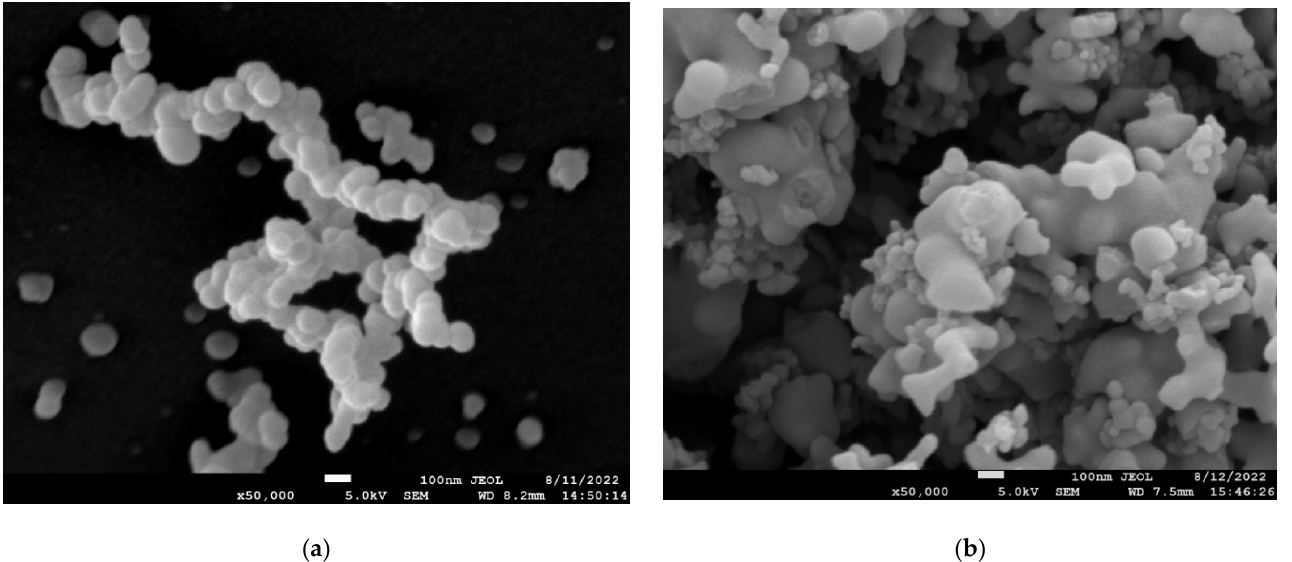
Figure 7. SEM images of char residues of ( a ) pure epoxy resin and ( b ) epoxy resin + 1 wt.% of compound 4b .